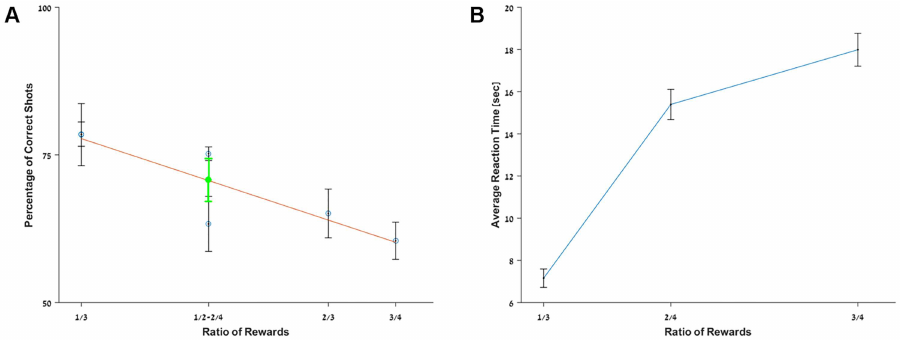
Fig 7. Ratio effect and fish reaction. A . Effect of value ratio over success rate; the values represent the averageover the last three days of the experiment. The error bars represent the standarderror. The linear regression is depictedin red. B . Effect of value ratio over reaction